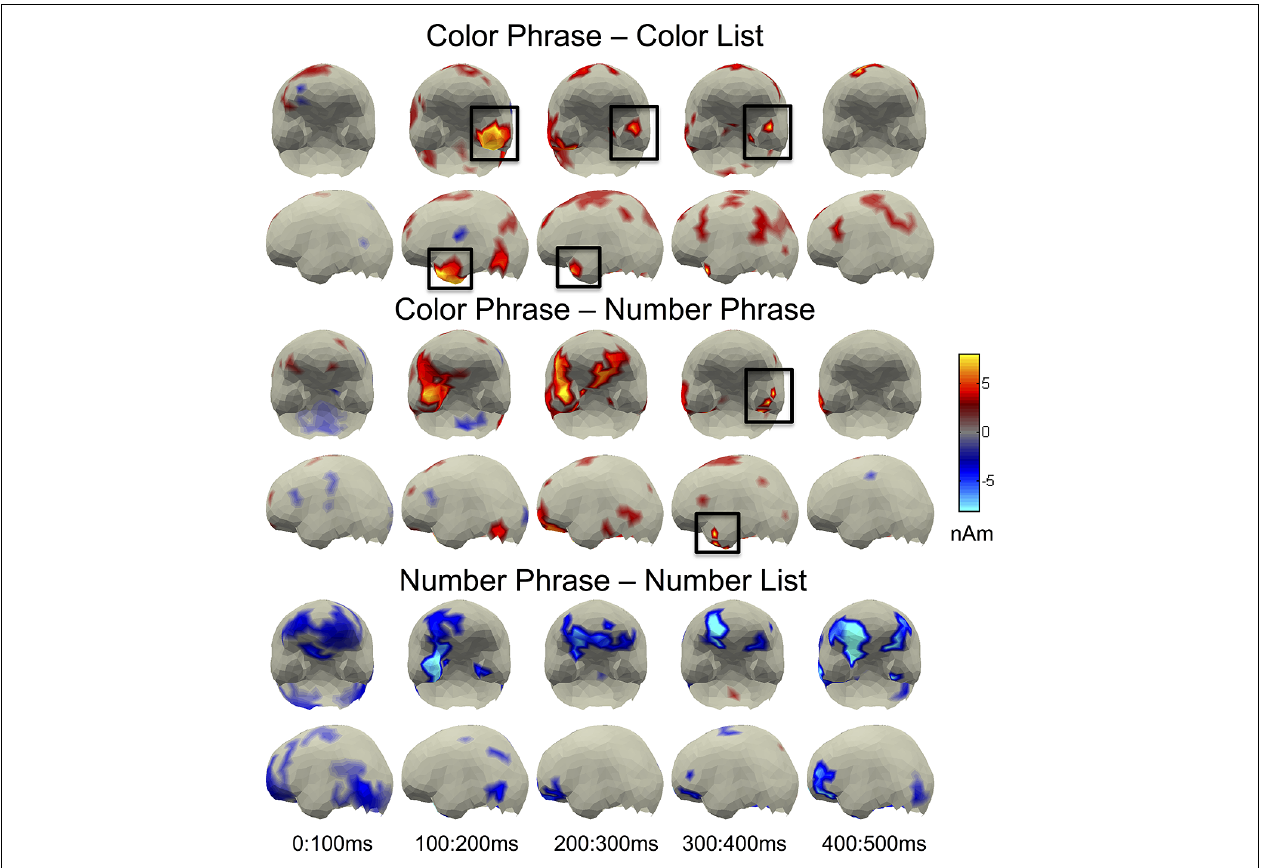
FIGURE 3 |Whole brain contrasts for pairwise comparisons. LATL effects corresponding to the ROI results are indicated with black